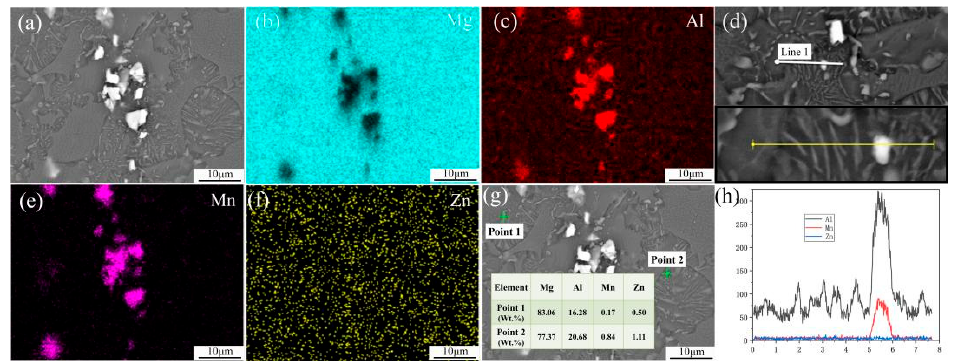
Figure 5. EDS mapping of the main alloying elements, spot and linear analysis of as-extruded AZ91 in center area: ( a ) SEM image; ( b ) Distribution of Mg element; ( c ) Distribution of Al element; ( d ) Linear scanning; ( e ) Distribution of Mn element; ( f ) Distribution of Zn element; ( g ) Main element content obtained by spot analysis; ( h ) Element spectrum of Al, Mn and Zn obtained by linear scanning.